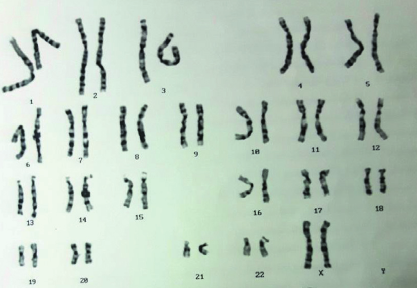
Figure 4: Karyotype study. It shows a normal female karyotype.